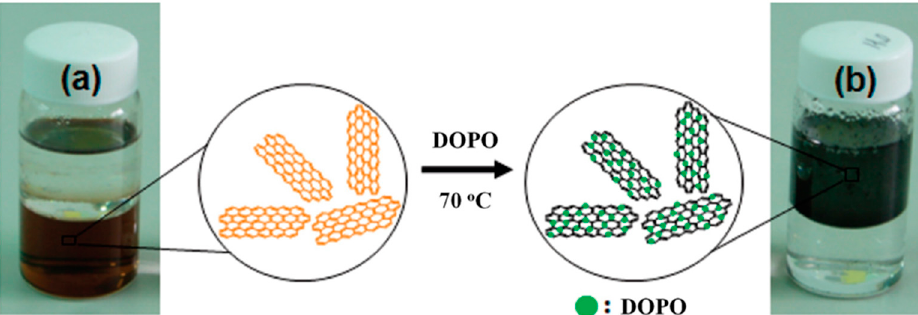
Figure 7. Photographs of ( a ) GO and ( b ) DOPO-reduced GO dispersions in water (bottom) and toluene (top) for 1 month. Reprinted with permission from [74]. 2012, Ind. Eng. Chem. Res.